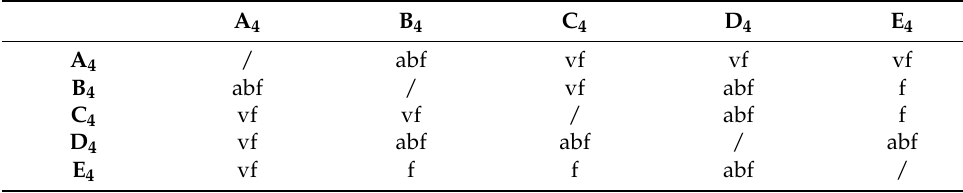
Table 18. Distance relations in the database scene (d) in Figure 17.